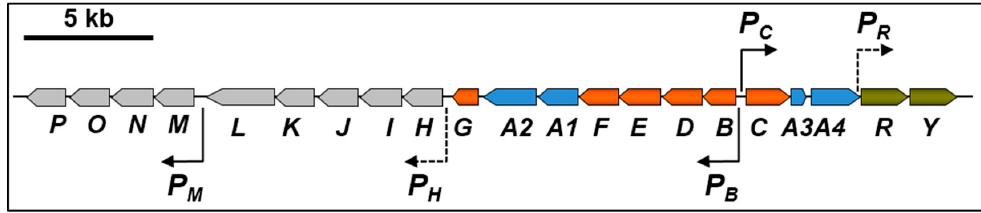
Figure 1. Organization of the chromosomal thn genes in TFA. The arrows show the directions of gene transcription. Bent arrows represent the identified promoters. Dashed lines represent internal promoters.